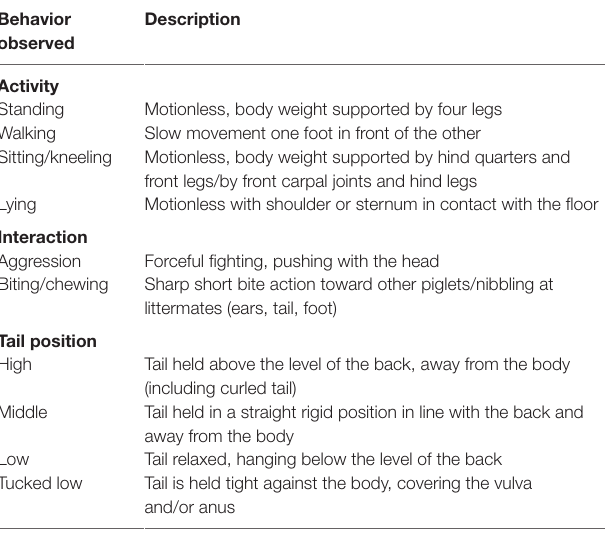
TaBle 1 | Description of behaviors and tail position recorded pre- and immediately post-docking.